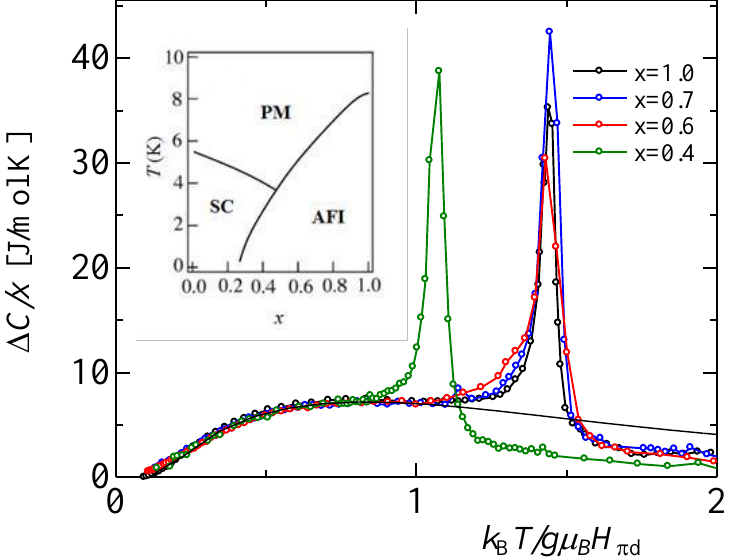
Figure 9. Δ C / x versus the temperature normalized by the internal magnetic field k T / gμ H . The inset is T - x phase diagram of λ -BETS B B πd